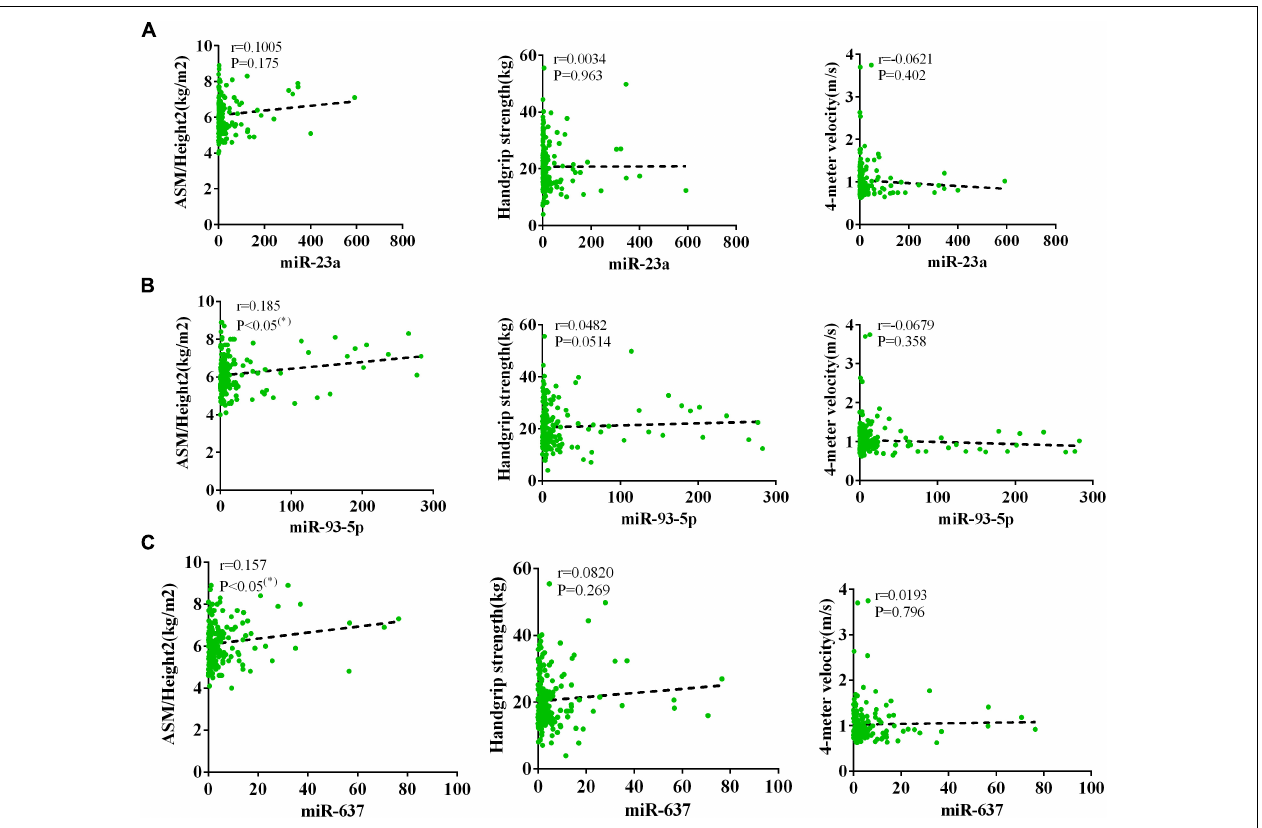
FIGURE 3 | Correlation analysis between the changes in (A) miR-23a-3p, (B) miR-93-5p, and (C) miR-637 and ASM/height 2 (kg/m 2 ), handgrip strength (kg), and 4-m velocity (m/s). The correlation between the changes in miR-23a-3p, miR-93-5p, and miR-637 and the diagnostic indicators of sarcopenia (ASM/height 2 , handgrip strength, and 4-m velocity) in sarcopenic and non-sarcopenic subjects. Pearson’s method was used for correlation analyses;* P < 0.05; n =